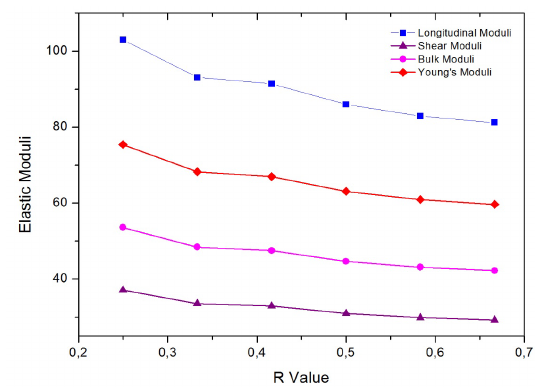
Figure 2. Variation of elastic modules for the BPS glass system. Source: the autors (2018).